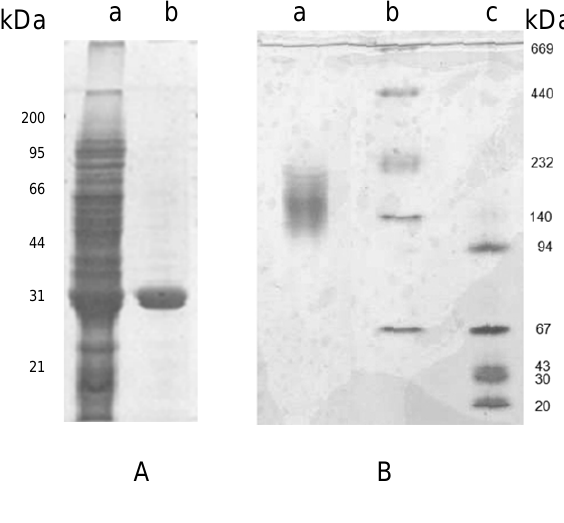
Figure 2. Electrophoretic analysis of the crude extract and pure lectin fractions from tepary beans on SDS-PAGE (Panel A) and Native PAGE (Panel B). Lane a in Panel